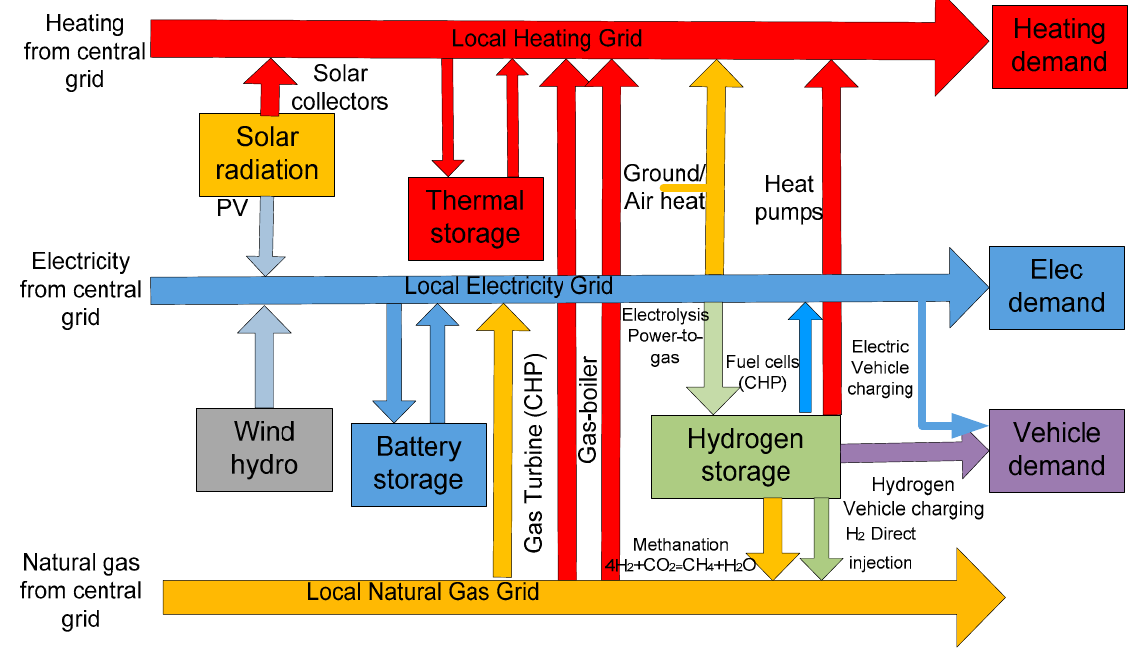
Figure 2. An illustration of a multi-vector energy system .